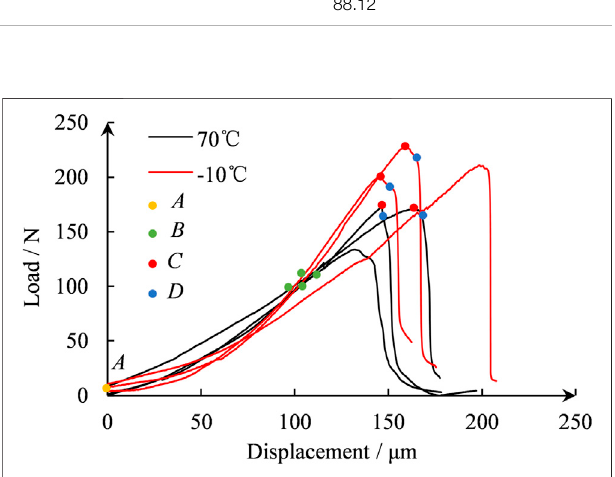
FIGURE6| Load – displacementcurves ofthree-point bending